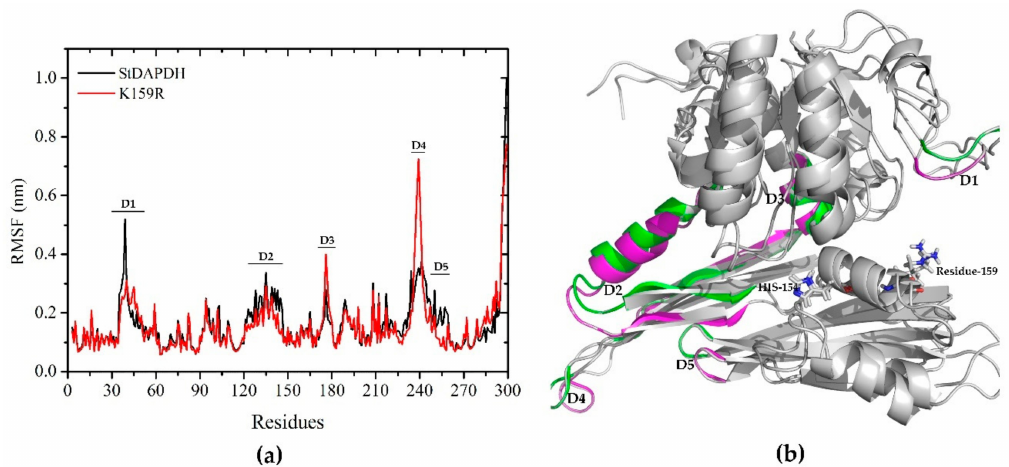
Figure 4. Root mean square fluctuation (RMSF) analysis ( a ) of wild-type (black) and K159R mutant (red) proteins. Residues and corresponding secondary structures ( b ) showing di ff erences in fluctuation are marked as D1, D2, D3, D4, and D5. Green: wild-type; magenta: